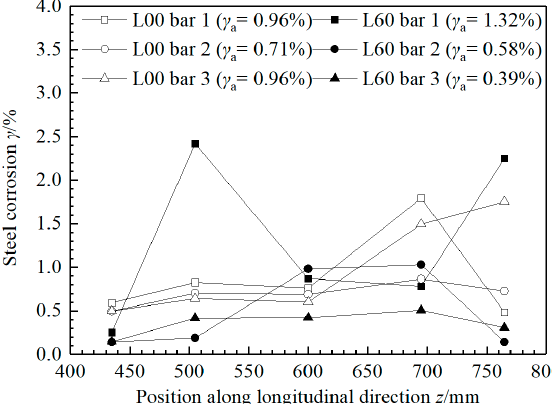
Figure 7. Longitudinal non-uniform corrosion of the longitudinal bars.